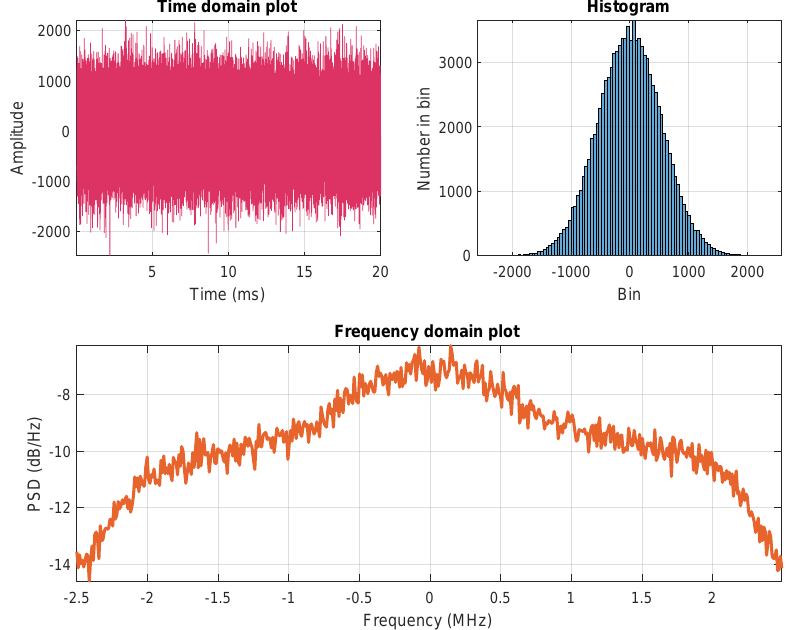
Figure 8. Analysis of the collected GNSS raw samples in time domain ( top ) and frequency domain ( bottom ). PSD: power spectral